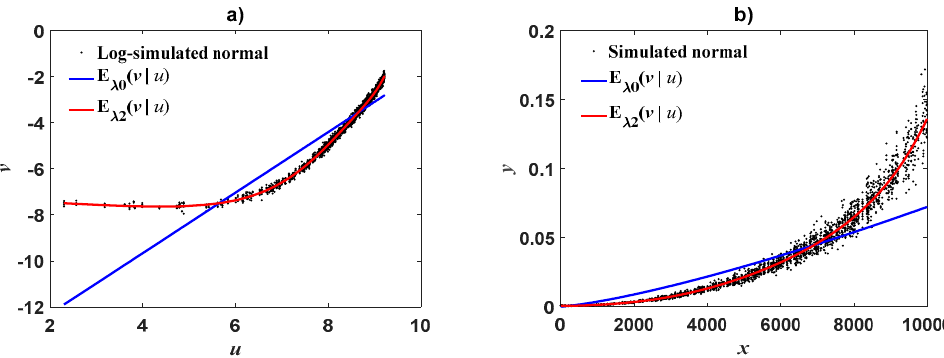
Figure 2. Fit of MCA on simulated data (𝑢 (cid:3036) , 𝑣 (cid:3030)(cid:3038)((cid:3036)) (𝜖)) . Regression Equation (46) was fitted to simulated (𝒖 𝒊 , 𝒗 𝒌(𝒊) ) data pairs. Panel ( a ) shows dispersion of 𝒗 𝒌(𝒊) about the mean response function 𝜆 (cid:2870) (𝑢). This plot also shows the traditional analysis method of allometry’s (TAMA) fitted mean response 𝜆 (cid:2868) (𝑢) . We can ascertain notorious bias by this last approach. Panel ( b ) shows corresponding retransformation results. Compared to significant reproducibility of mean response 𝐸 (cid:3090)(cid:2870) (𝑦|𝑥) TAMA’s counterpart 𝐸 (cid:3090)(cid:2868) (𝑦|𝑥) entails significant bias.